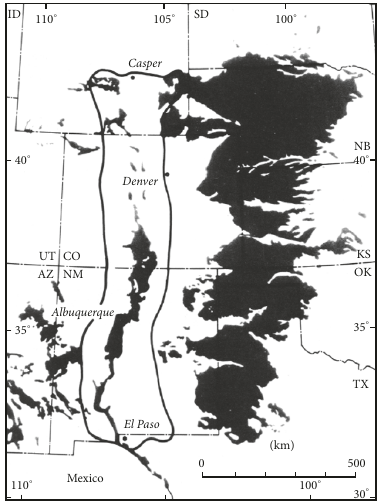
Figure 5: Distribution of Miocene and Pliocene sedimentary rocks (shaded) on the Eaton Alvarado ridge. These sediments lie in a chain of deep medial grabens (like in the Rio Grande rift in NM and southern CO) and in thin blankets on the flanking rises of the ridge. The region around the crest of the Alvarado ridge is outlined by a heavy solid line. The large continuous shaded area in the east, runningfromNebraskadowntotheTexasPanhandle,istheOgallala Formation (Figure 4 of